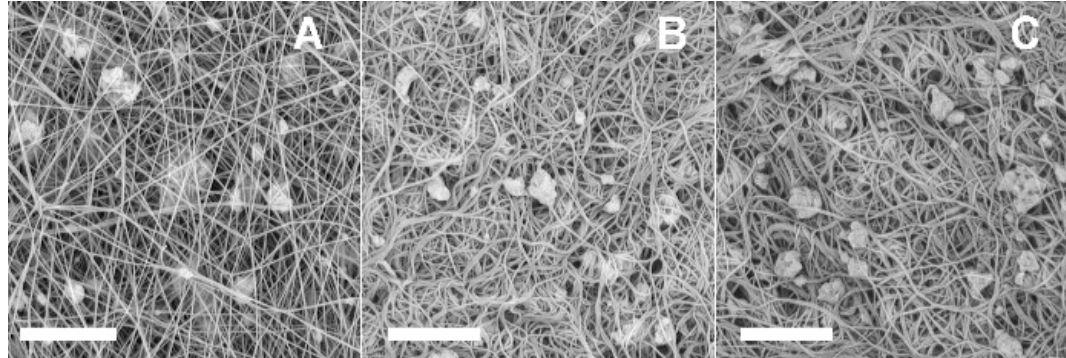
Figure 6. SEM micrographs of ( A ) NYL + AuPd + TiO 2 ; ( B ) NYL + AuPd + TiO 2 after reaction at 90 °C and ( C ) NYL + AuPd + TiO 2 after reaction at 110 °C; scale bar: 5 μ m.